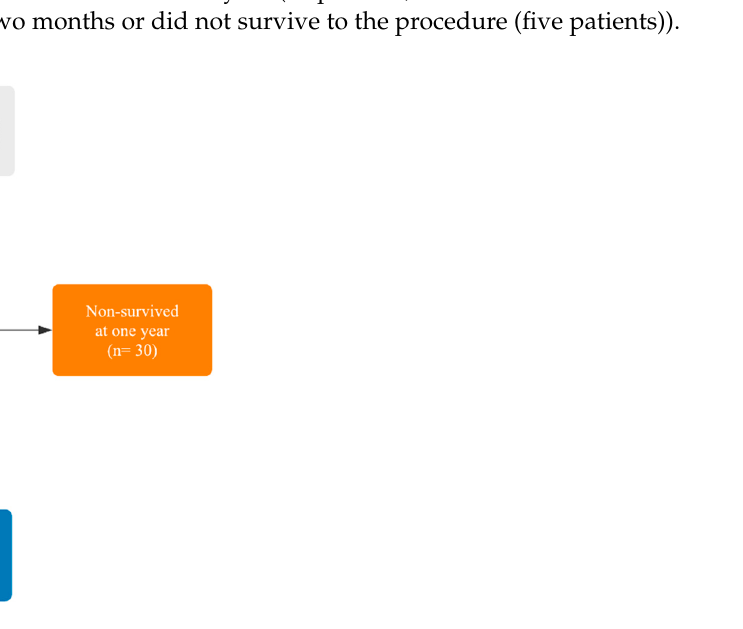
Figure 2. Flow of participants representing the study population. Survival distribution details are shown in Figure A2 (Appendix A).